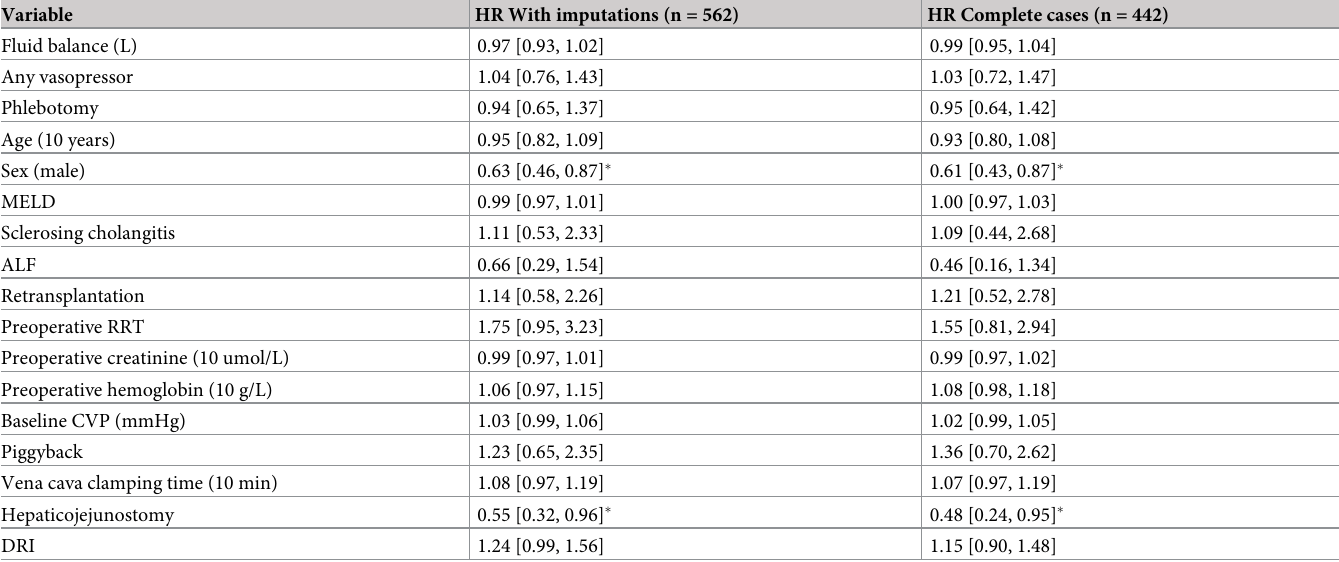
(Table 5 and S9 Fig in S2 Appendix). We observed no interaction between vasopressor and fluid balance on any outcome and our results were robust to complete cases analyses. As a post-hoc analysis, we explored the cross-sectional association between any hepatic artery complication and biliary complications (Table 6). Hepatic artery stenosis was reported in 10% of patients (37 out of 370) with no biliary complications and 19% of patients with any biliary complication (36 out of 192; 26 out of 167 with AS (16%) and 17 patients out of 56 with